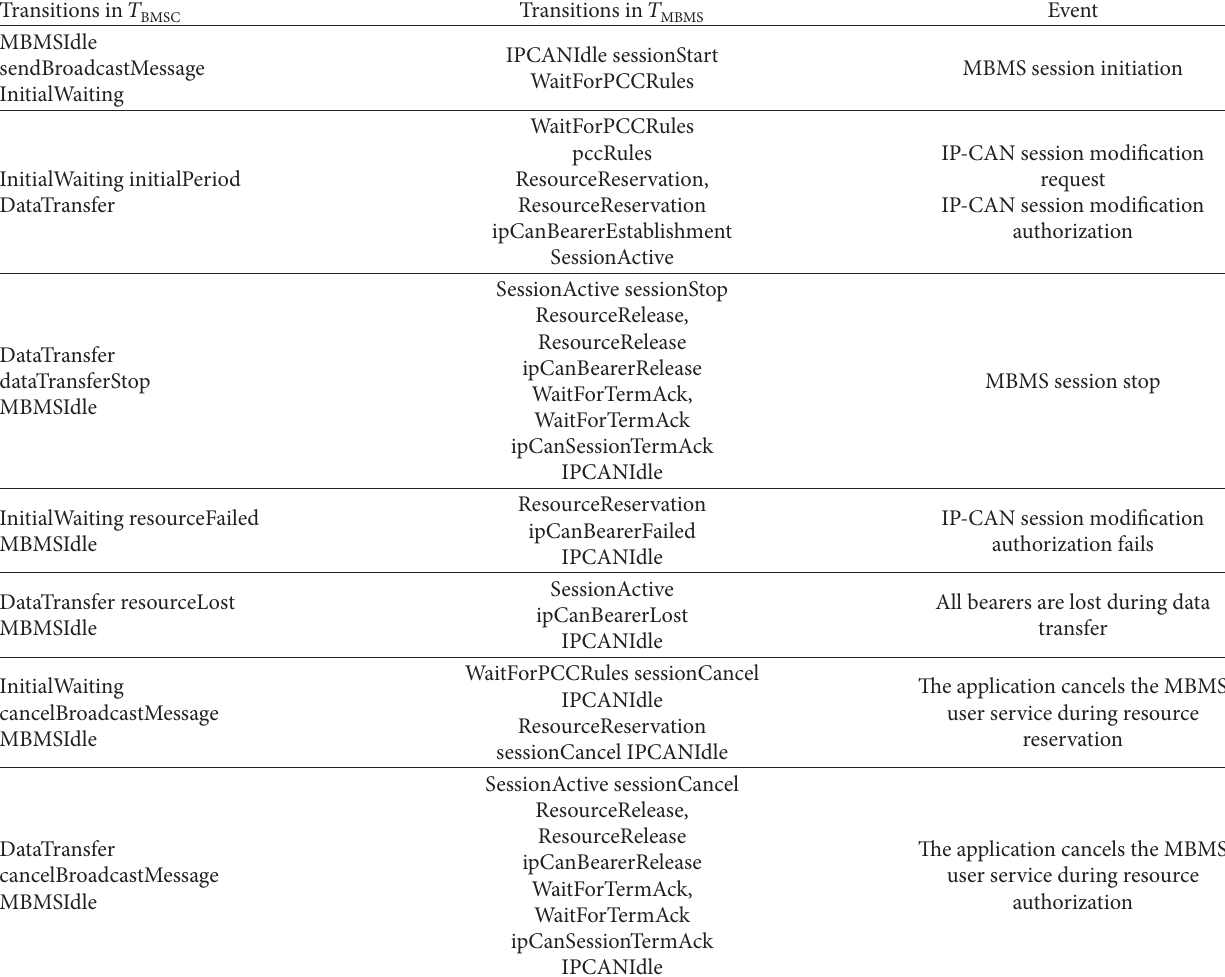
Table 2: Functional mapping between transitions of 𝑇 BMSC and 𝑇 MBMS